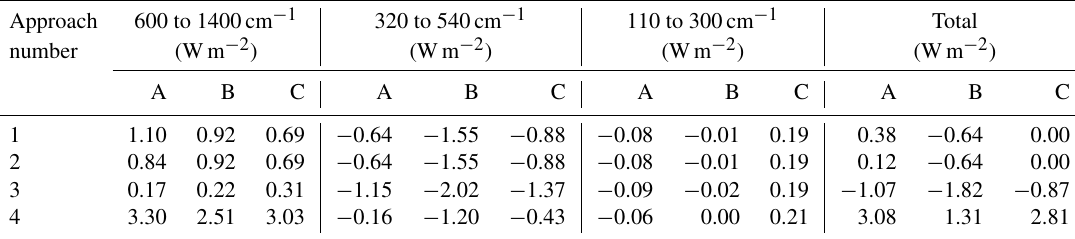
Figure 7. Simulation minus observation difference spectra for case A for each minimization approach, for the (a) MIR, (b) SW FIR and (c) LW FIR frequency ranges. The transmission of the atmosphere (derived from a simulation) between the cloud top and the aircraft level is also shown. Table 4. Integrated, simulation minus observation, flux differences for selected spectral ranges (MIR, SW FIR and LW FIR) as well as the total, for the best-matching spectra obtained using the four different minimization methods, for the three case studies. Results from method 4 are included for completeness, although we do not anticipate future observations to be restricted to only FIR frequencies. Approach 600 to 1400cm −